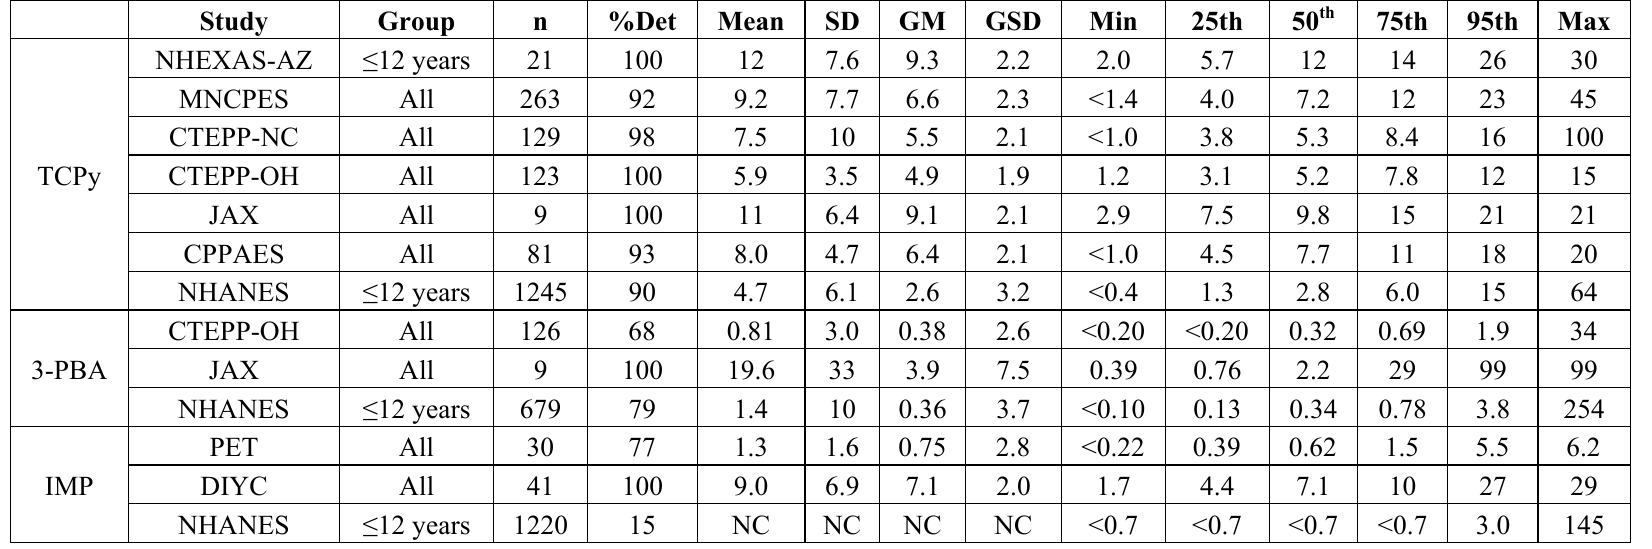
Table 3. Summary statistics for the pesticide metabolites TCPy, IMP, and 3-PBA measured in the children’s urine samples by study (ng/mL). NHANES results are included for